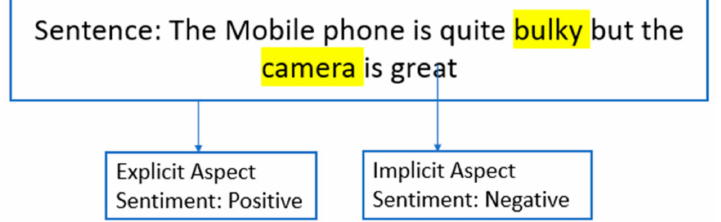
Figure 3. An example of implicit and explicit